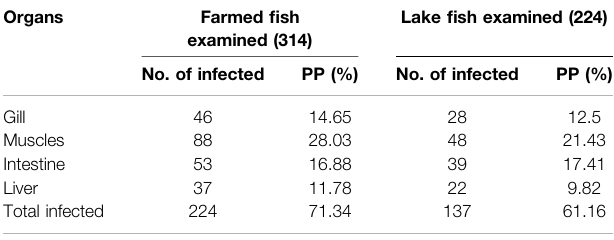
TABLE 3 | Number of infected specimens of O. niloticus considering the different analyzed organs and their percentage on the total number of fi sh examined. Organs Farmed fi sh Lake fi sh examined (224) examined (314) No. of infected